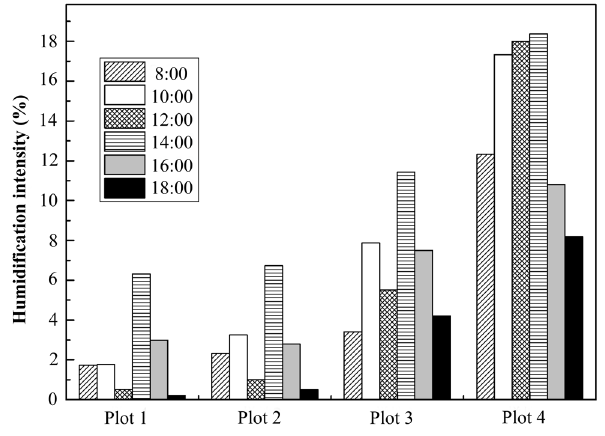
Figure 5. Comparison of different humidification effects between 8 and 18 o’clock.